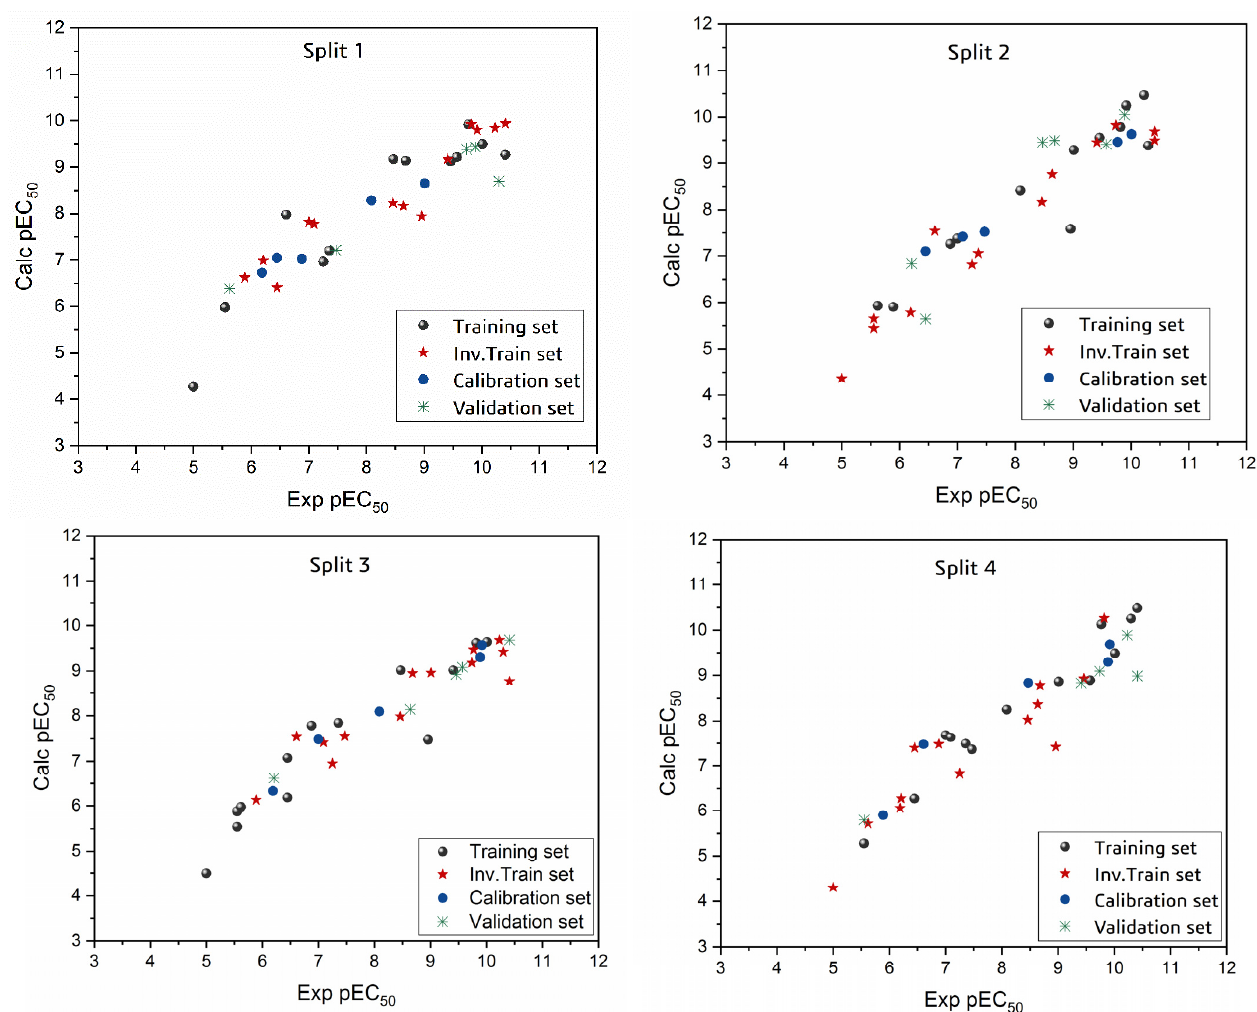
Figure 1. Experimental versus calculated pEC 50 values for the models (i.e., Four Splits).